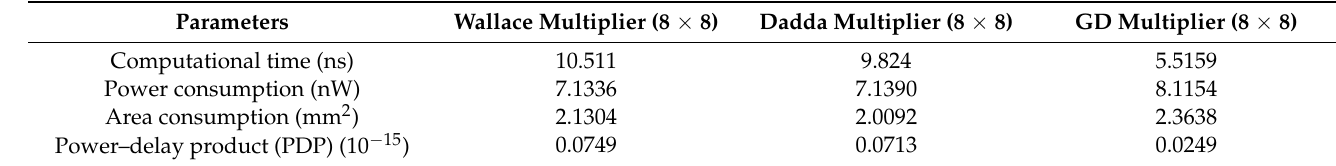
Table 4. Back-end design performance comparison between the proposed multiplier and existing multiplier